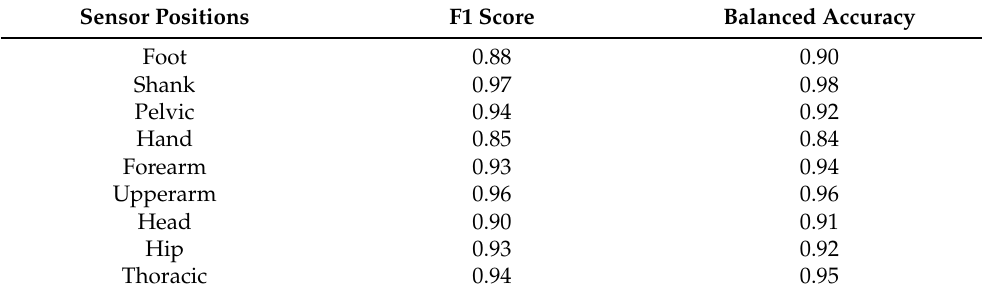
Table 3. Results for various sensor